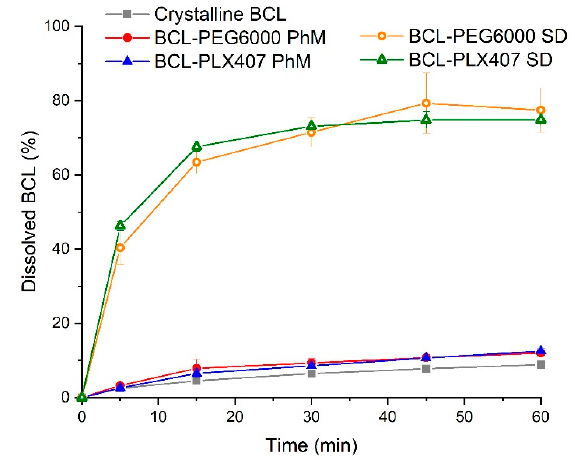
Figure 5. Dissolution of bicalutamide from solid dispersions with Macrogol 6000 and Poloxamer ® 407 in comparison with physical mixtures and crystalline bicalutamide (form I polymorph).